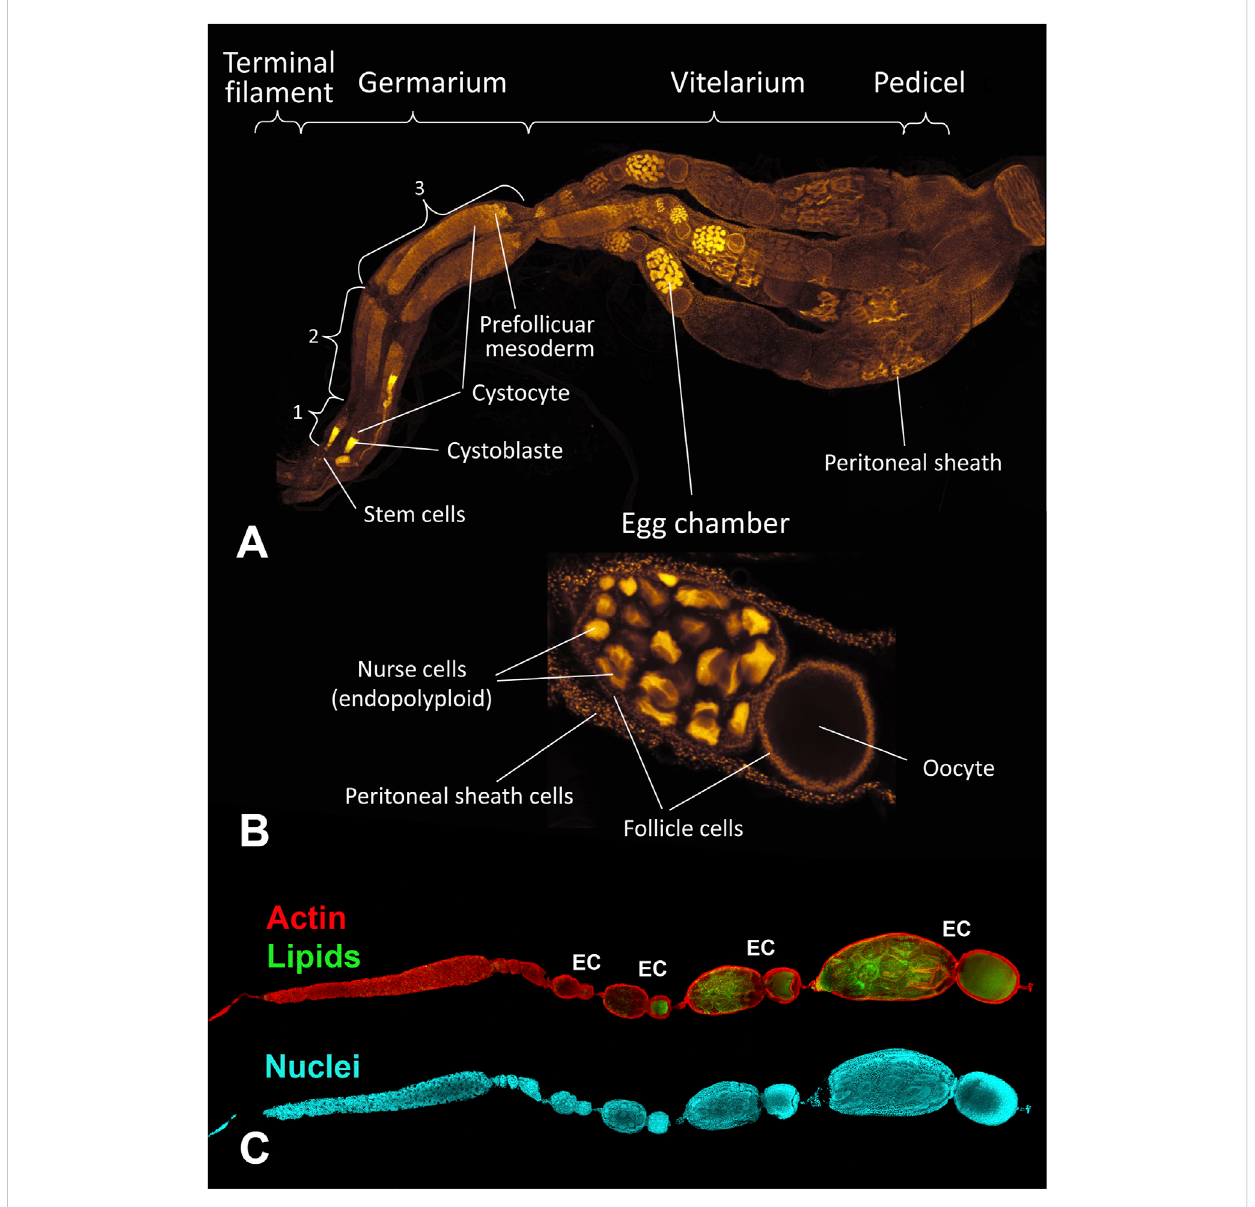
The B. terrestris ovary of a 3 day-old unfertilized queen. (A) The ovary is formed by four ovarioles, each divided into four parts: the terminal fi lament, the germarium, the vitellarium, and the pedicel. 1, 2, 3: anterior, middle, and posterior regions of the germarium containing cystoblasts that convert to cystocyteswhichdifferentiateintooocytesandnursecells.Theprefolliclemesodermgivesrisetofolliclecells. (B) Aneggchambersurroundedbyfollicle cells comprises 63 nurse cells with endopolyploid nuclei and an oocyte. Each ovariola is covered by the peritoneal sheath. (C) A single ovariole, devoid of the peritoneal sheath with developing egg chambers (EC). Actin fi laments are labeled by phalloidin (red), accumulating lipids are stained by BODIPY (green) and nuclei by DAPI